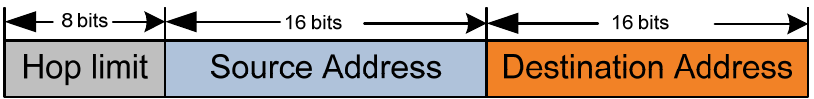
Figure 4. Addressing format to communicate within a